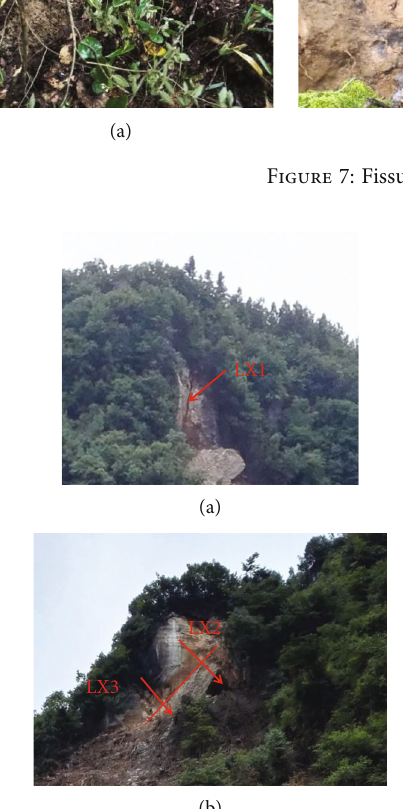
Figure 8: Distribution of joints and fi ssures in the investigation